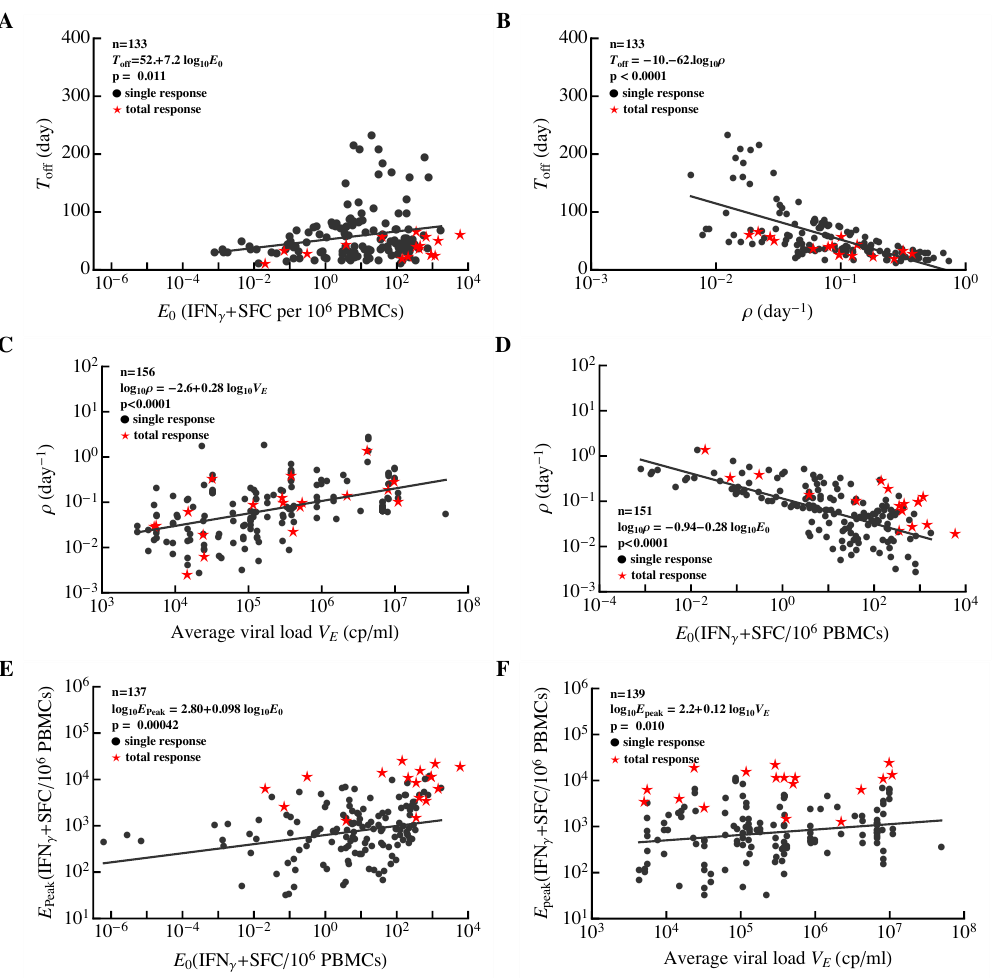
Figure 7. Correlations between major parameters determining dynamics of HIV-specific CD8 + T-cell responses in acute infection. For all epitope-specific CD8 + T-cell responses in all 22 patients (circles) or the total HIV-specific CD8 + T-cell response per patient (stars), we estimated the initial frequency of epitope-specific CD8 + T cells ( E 0 ), rate of expansion of T-cell populations ( ρ ), time of the peak of the response ( T off ), rate of contraction of the immune response after the peak ( α ), predicted peak values reached by the epitope-specific CD8 + T-cell response ( E peak = E ( T off ) ), and the average viral load ( V E ). Solid lines denote regression lines; regression equations and p values are indicated on individual panels for all epitope-specific CD8 + T-cell responses. The total HIV-specific CD8 + T-cell response showed a similar trend to all epitope-specific CD8 + T-cell responses. Panels show correlations between the timing of the immune response peak T off and predicted frequency E 0 ( A ), T off and ρ ( B ), expansion rate ρ and average viral load V E ( C ), ρ and E 0 ( D ), peak immune response E peak and E 0 ( E ), and E peak and V E ( F ). For a given patient, we calculated the total HIV-specific CD8 + T-cell response as the sum of all epitope-specific CD8 + T-cell responses at the same time point (i.e., by ignoring “nd”). For patient MM42, we could not fit the T on / T off model to the dynamics of total CD8 + T cell response data because of wide oscillations in the data. Identified relationships did not change if estimates for responses with unphysiological initial frequencies ( E 0 ≤ 10 − 2 ) were excluded from the